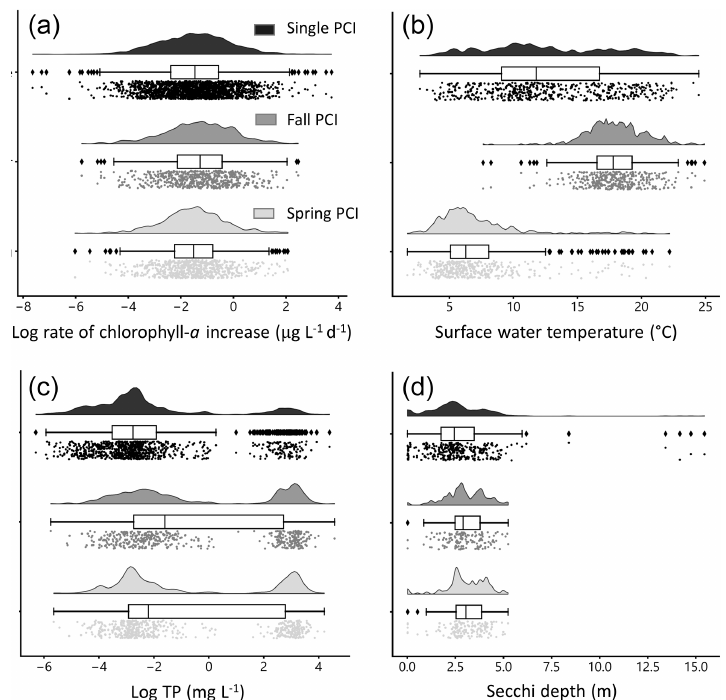
Figure 6. Distributions of selected water quality variables during PCIs: (a) log rate of chlorophyll- a increase, (b) mean surface water temperature, (c) log mean total phosphorus (TP), and (d) mean Secchi depth. The mean rate of chlorophyll- a increase is lowest in the single PCI category and highest in the fall PCIs. For the single PCIs, temperature is evenly distributed across the annual range, as they occur throughout the ice-free season. Total phosphorus concentrations are lowest during the spring PCIs, which likely reflects a greater control of P limitation on algal growth during spring compared to summer and fall. Each PCI category has a similar range in Secchi depth, between 0 and 5m. Rain-cloud plots show the frequency distribution, boxplot with quartiles (outliers as represented as points), and a jitter plot of data points for each